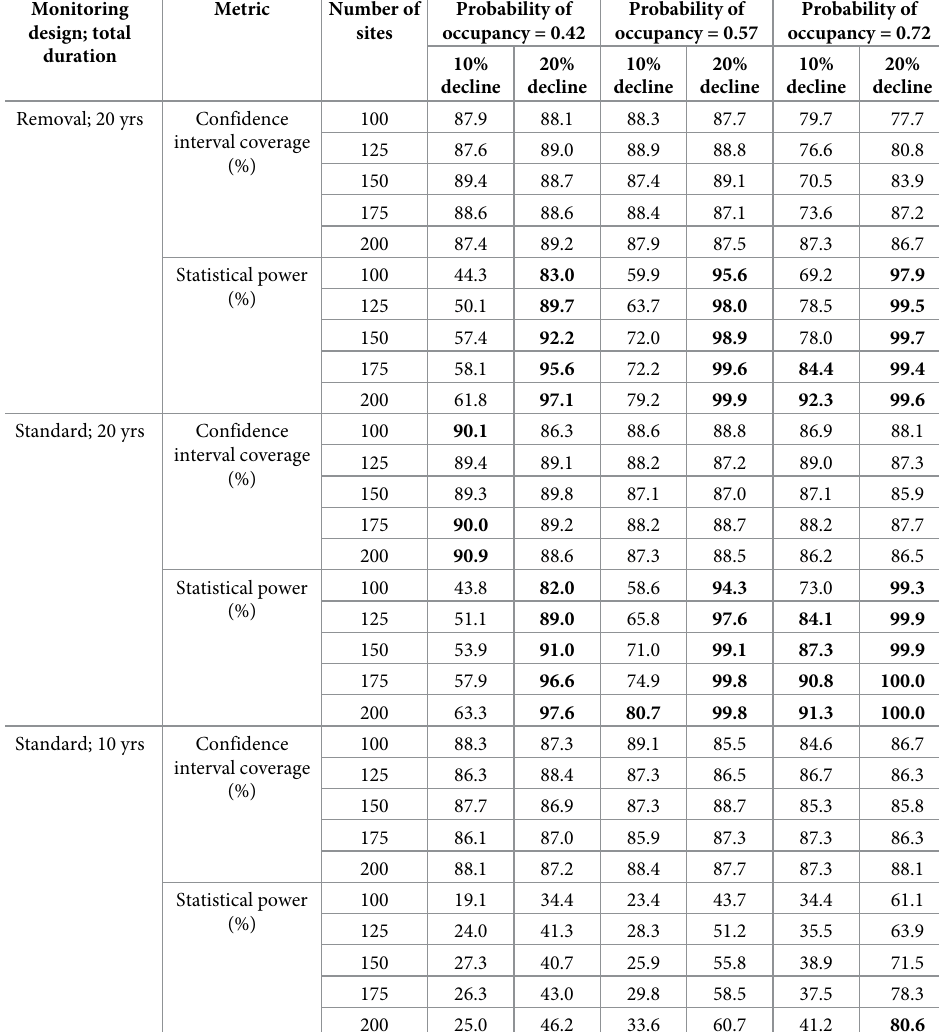
Table 3. Evaluation metrics for simulations increasing number of sites